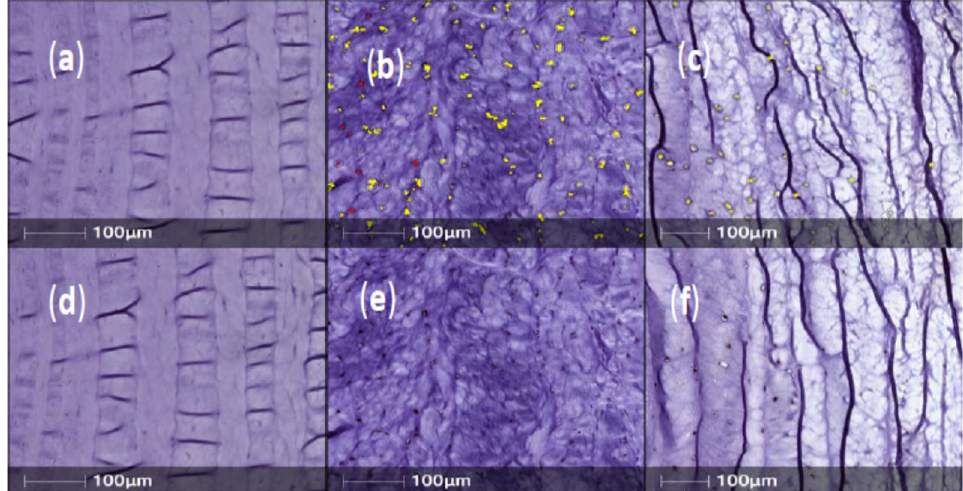
Figure 2. Representative sample of nerve growth factor receptor (NGFr/TrkA) expression in normal, PBS (n = 11) and NTG-101 (n = 16) injected IVDs. ( a – c ) Top panels show immunopositively stained cells overlaid in yellow by HALO automated cell counting software. ( d – f ) Identical sections without yellow overlay immunostained for TrkA with the DAB chromogen are shown in the bottom panels. Statistical analysis was performed using the Student’s t-test for the number of pos- itively stained cells in NTG-101 injected discs and compared to PBS (vehicle)